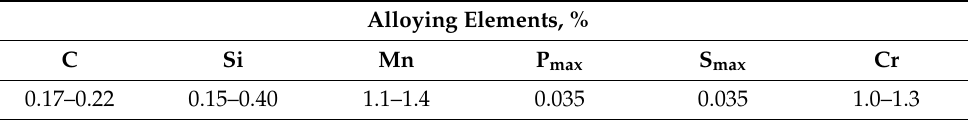
Table 1. Chemical composition of the 20MnCr5 steel